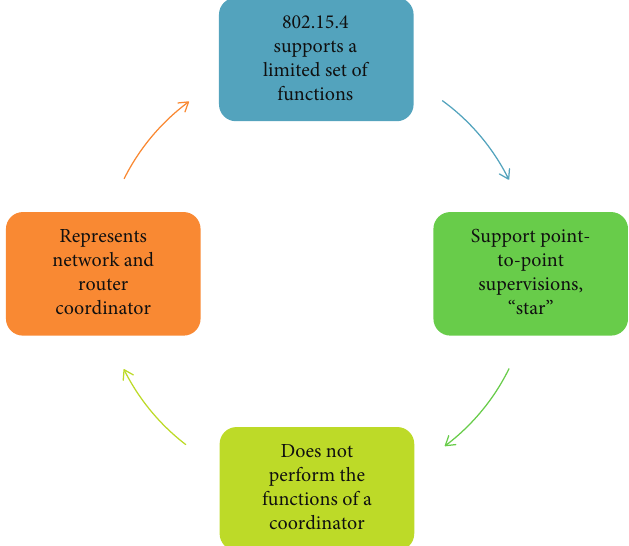
Figure 5: The performance parameters of reduced function